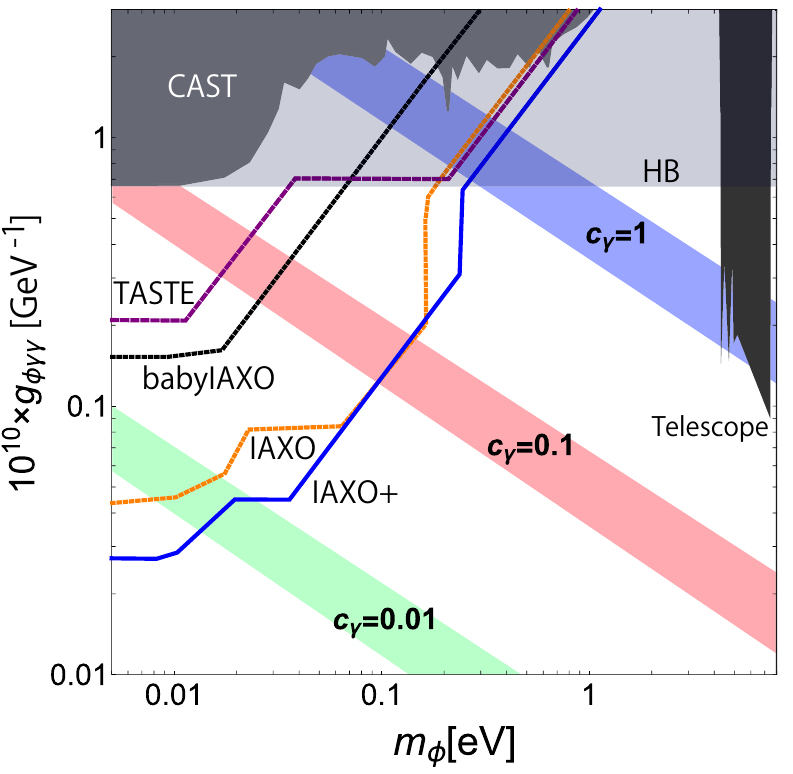
Figure 3 . The preferred region of g (cid:30)(cid:13)(cid:13) and m (cid:30) for c (cid:13) = 1 (blue), 0 : 1 (red), and 0 : 01 (green). The gray, light gray, and black regions are excluded by CAST, the cooling arguments of HB stars, and the optical telescopes, respectively [47{49]. The last constraint assumed the ALP dark matter. The purple, black, orange, and blue lines show the projected sensitivity reach of TASTE, baby IAXO, IAXO, and IAXO+, respectively [22{24, 50,